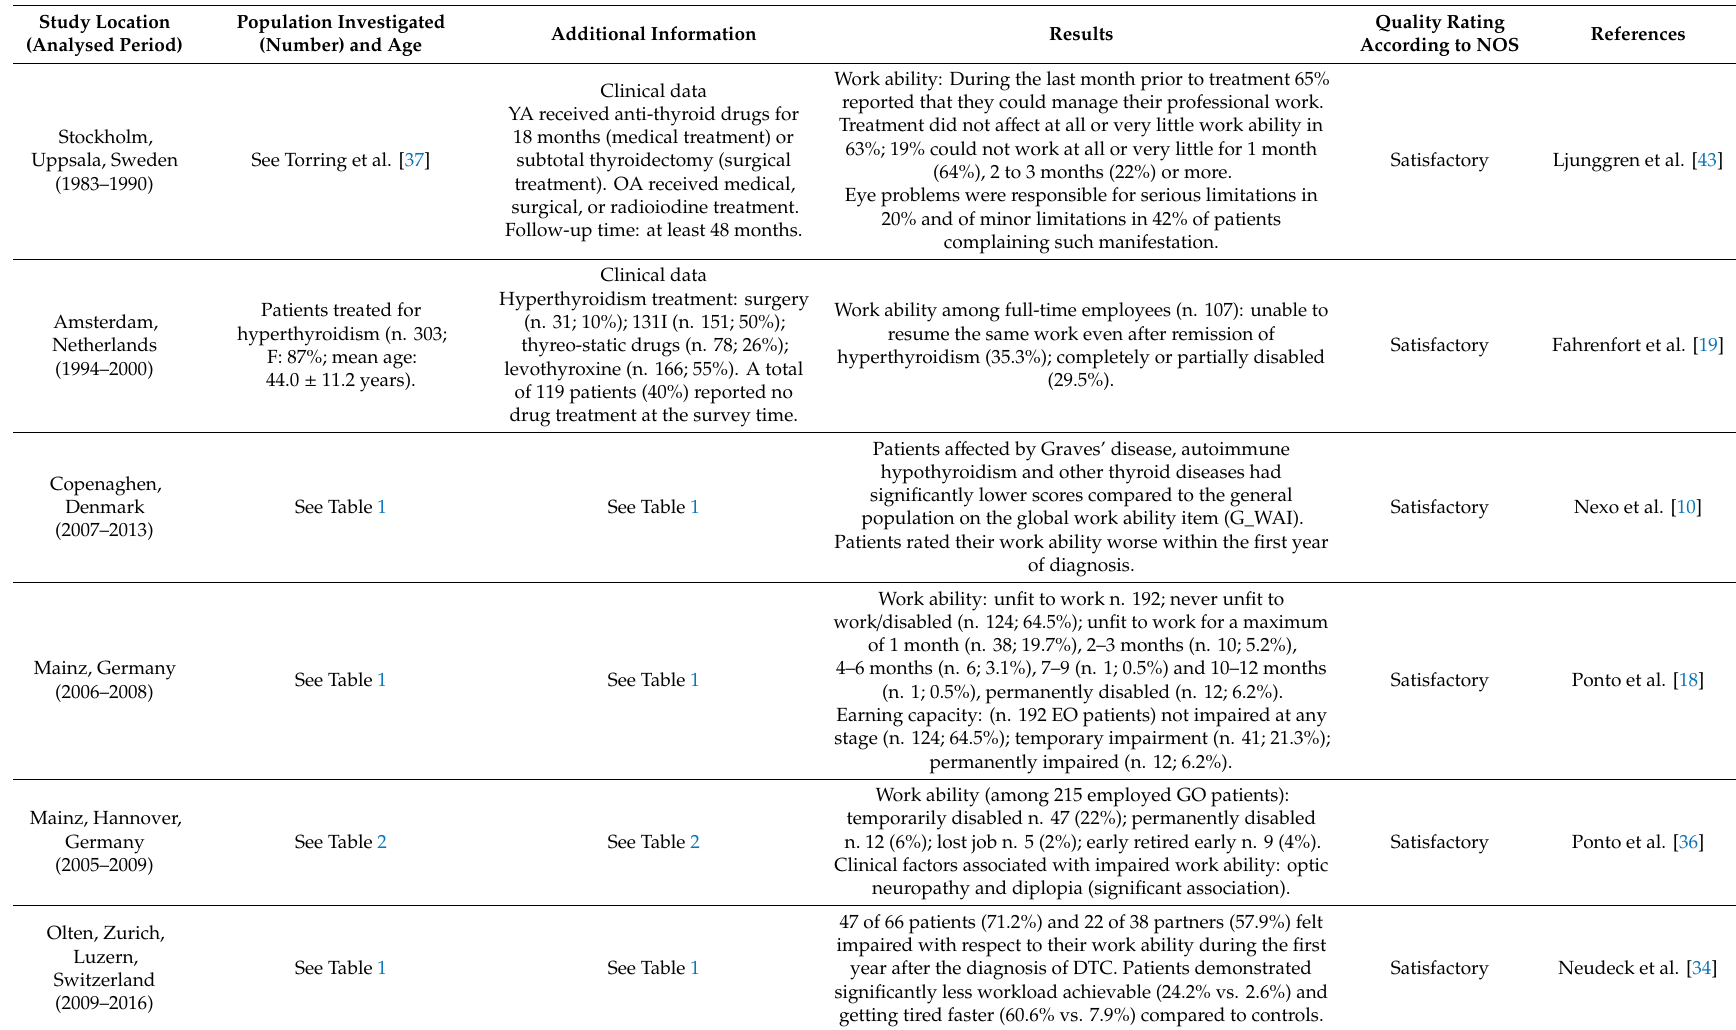
Table 3. Studies addressing the impact of thyroid disease on work